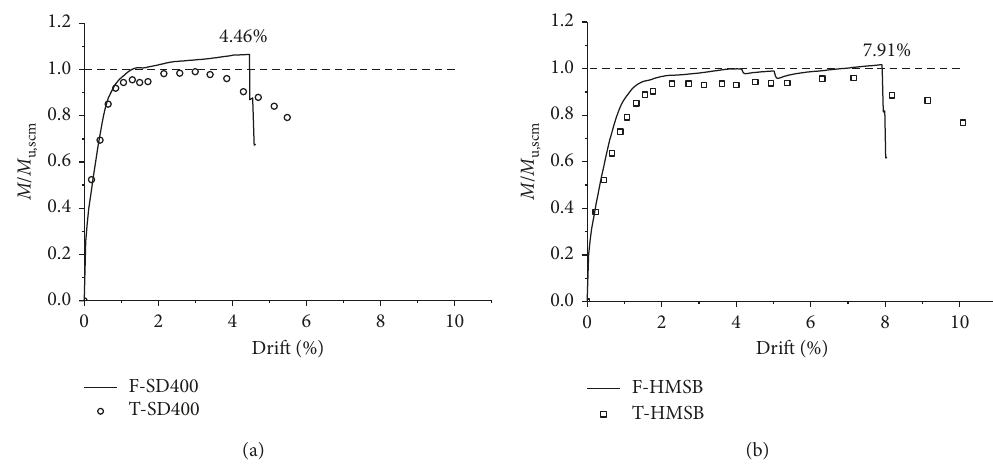
Figure 17: Verification results: (a) F-SD400 vs. T-SD400 and (b) F-HMSB vs. T-HMSB.